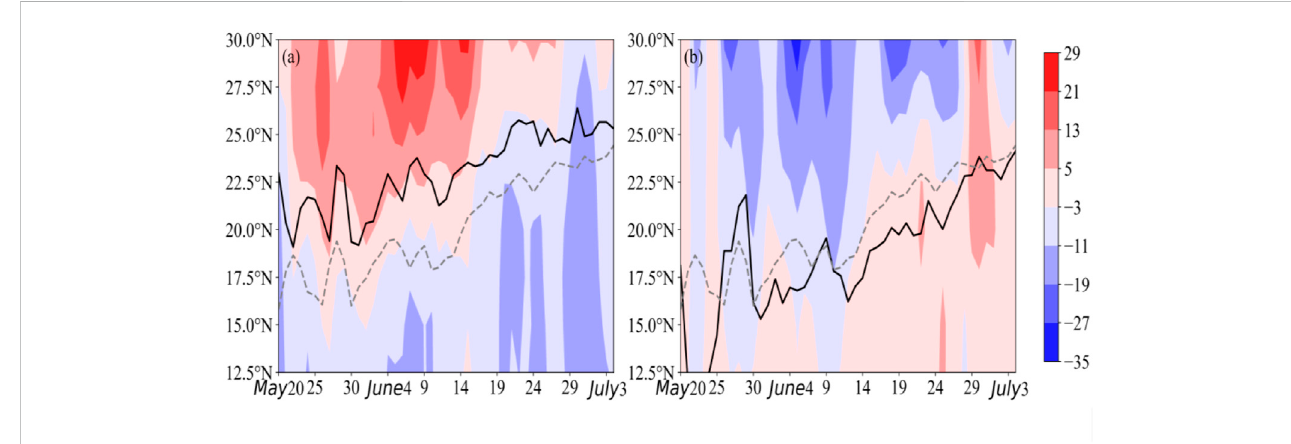
FIGURE 5 110 ° -140 ° E average of 500 hPa geopotential height time-latitude cross sections in the early and late years of Meiyu onset (A) : early years (B) : late years (The shaded area is the anomaly, and the dashed (solid) line represents the climatic average position (abnormal year) of the subtropical high